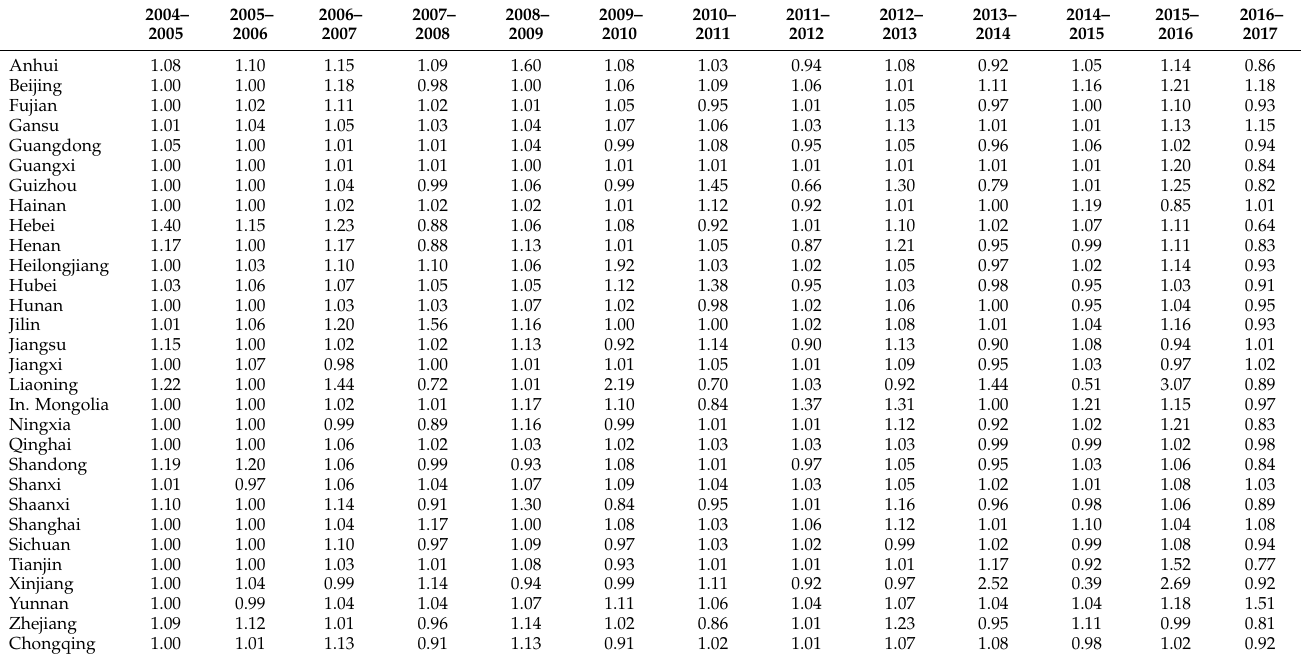
Table 8. Changes in eco-efficiency index of agricultural land in 30 provinces in